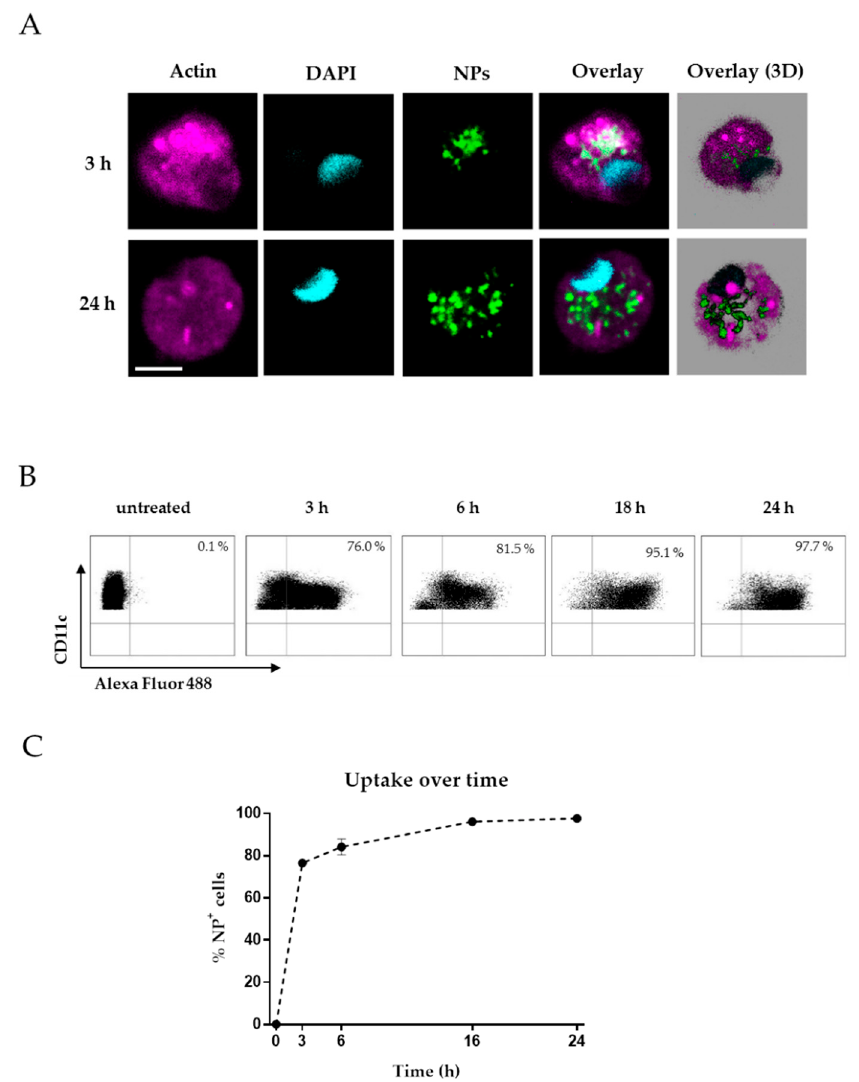
Figure 2. Uptake of functionalized CaP nanoparticles by dendritic cells (DCs). ( A ) Confocal laser